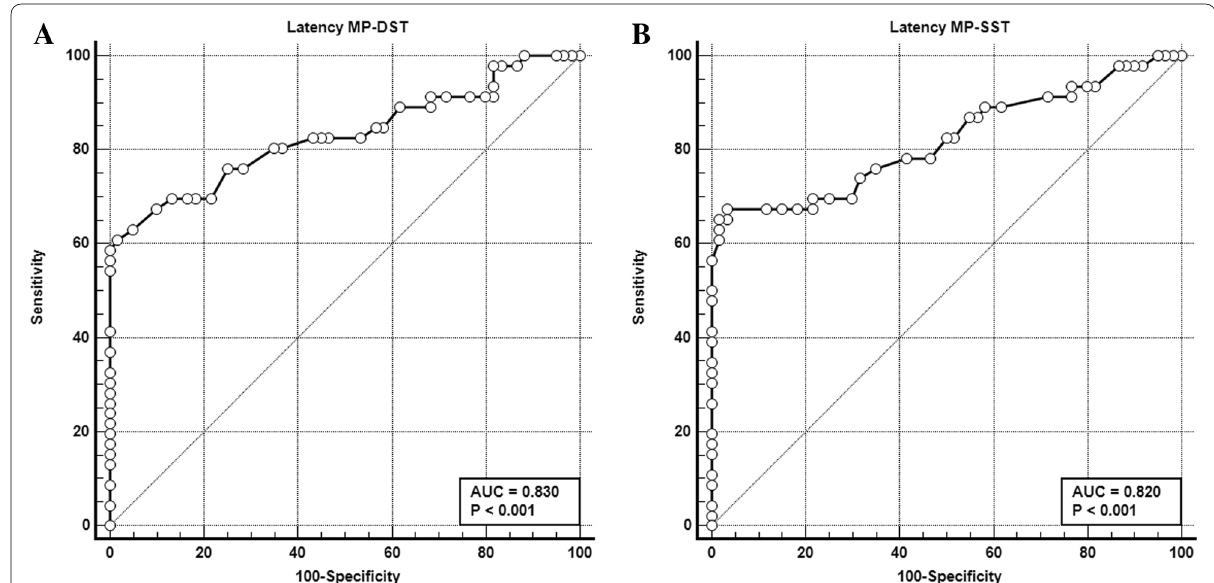
Fig. 3 Excellent discrimination of MP latency stance between the healthy and diseased feet during A double stance (AUC (AUC =